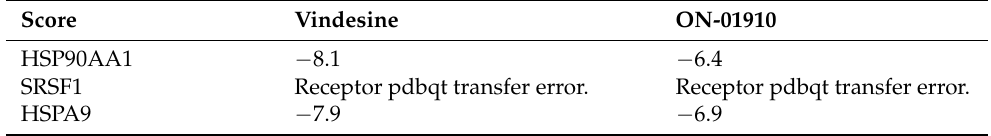
Table 2. Top 10 drugs with the highest negative correlations with the common DEGs predicted using cMAP. Table 3. Docking of the three hub genes with predicted drug